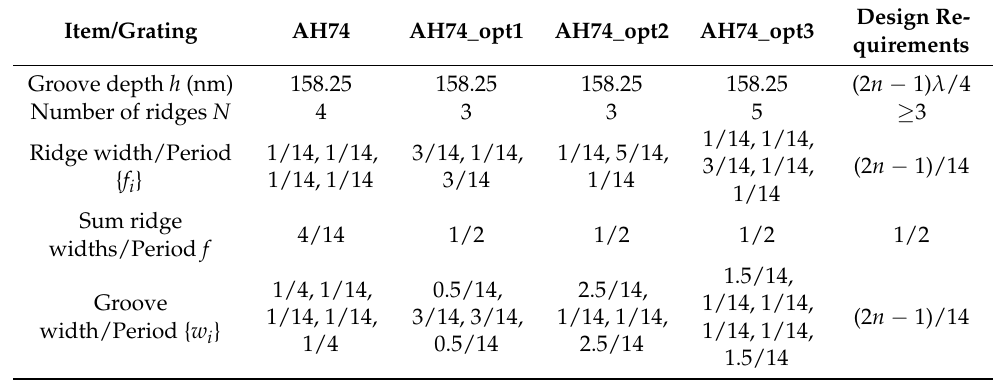
Table 4. The structure parameters of AH74, AH74_opt1, AH74_opt2, AH74_opt3.